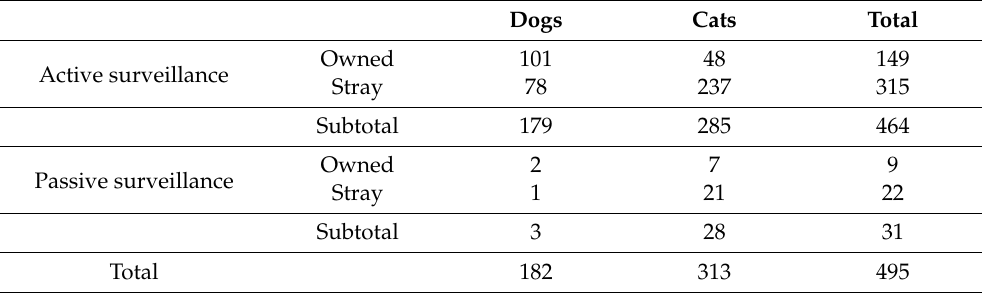
Table 1. Tested animals for active and passive surveillance. Dogs Cats Total Owned 101 48 149 Active surveillance Stray 78 237 315 Subtotal 179 285 464 Owned